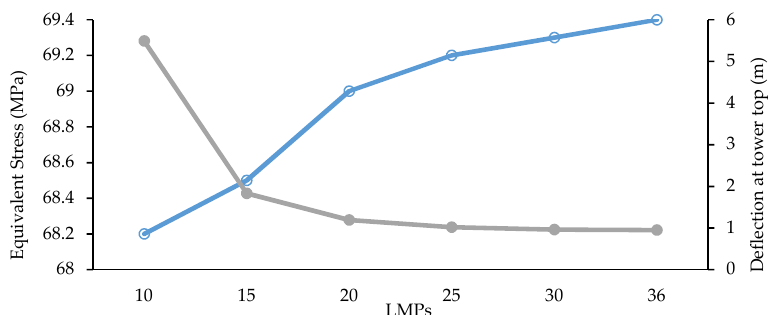
Figure 9. Evolution of the maximum equivalent stress (von Mises-open circles) and of the maximum deflection on the tower top (full circles), considering consecutive increases on the monopile length L MP .